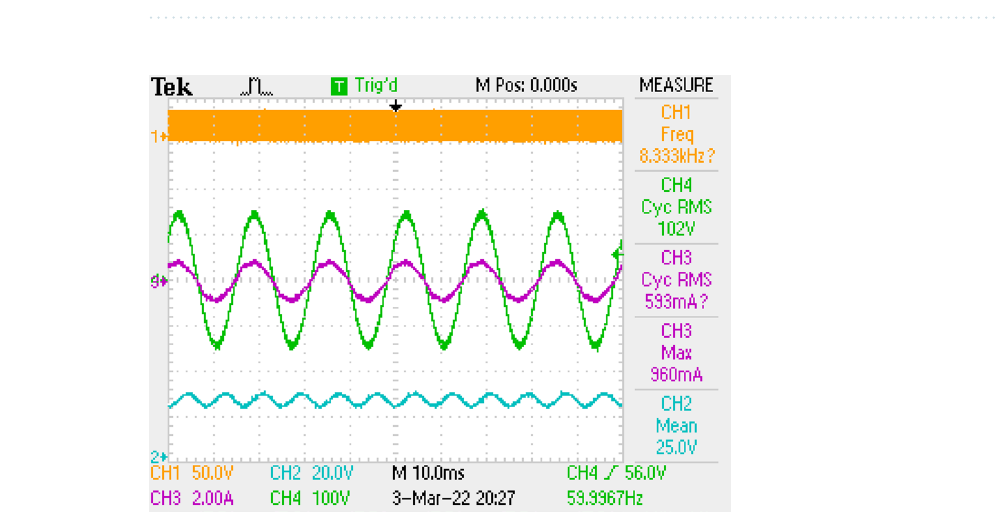
Figure 12. By LC DM filter, THD of grid current.